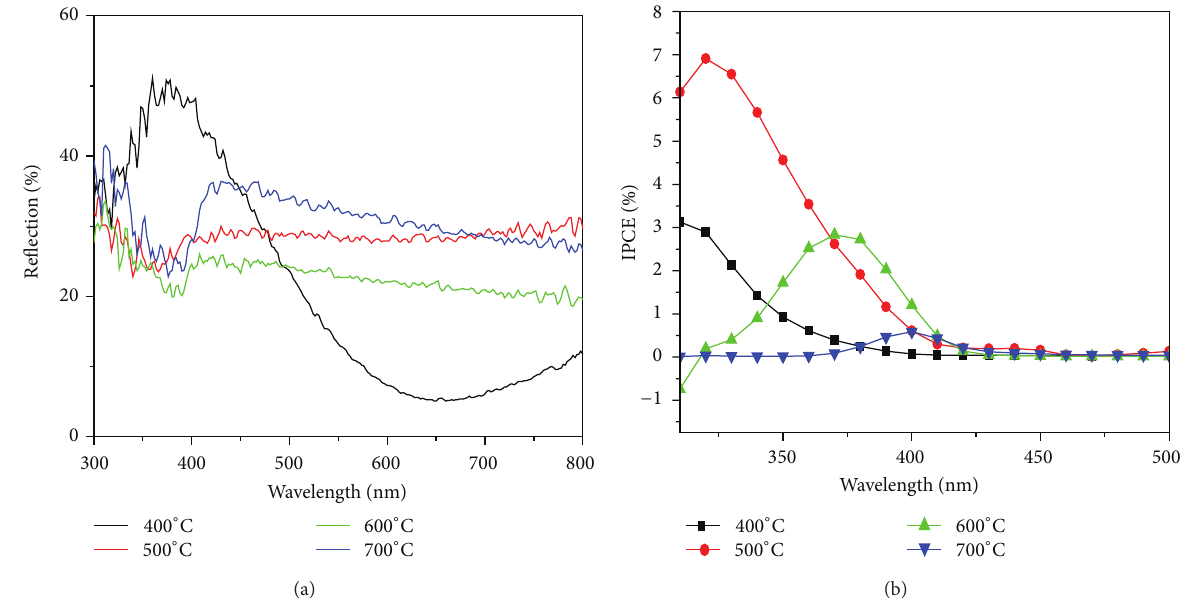
Figure 5: The UV-Vis diffuse reflection spectra (DRS) and monochromatic incident photon-to-electron conversion efficiency (IPCE) of the TiO 2 films formed by Ti implanted into Ti foil and subsequent annealing.